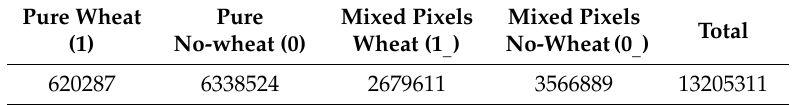
Table1. DatasamplesextractedfromModerateResolutionImagingSpectroradiometer(MODIS)images.